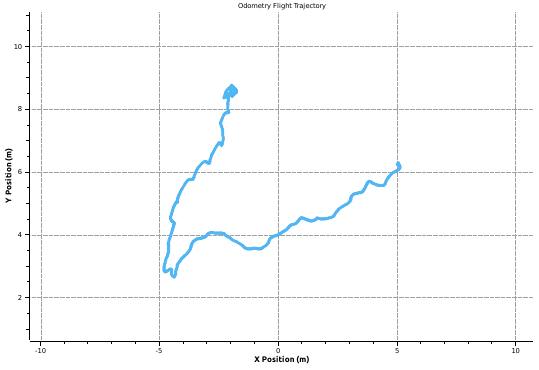
Figure 12: Trajectory of an autonomous flight using natural fea- ture based localization. It is accurately following the Vicon ground truth.